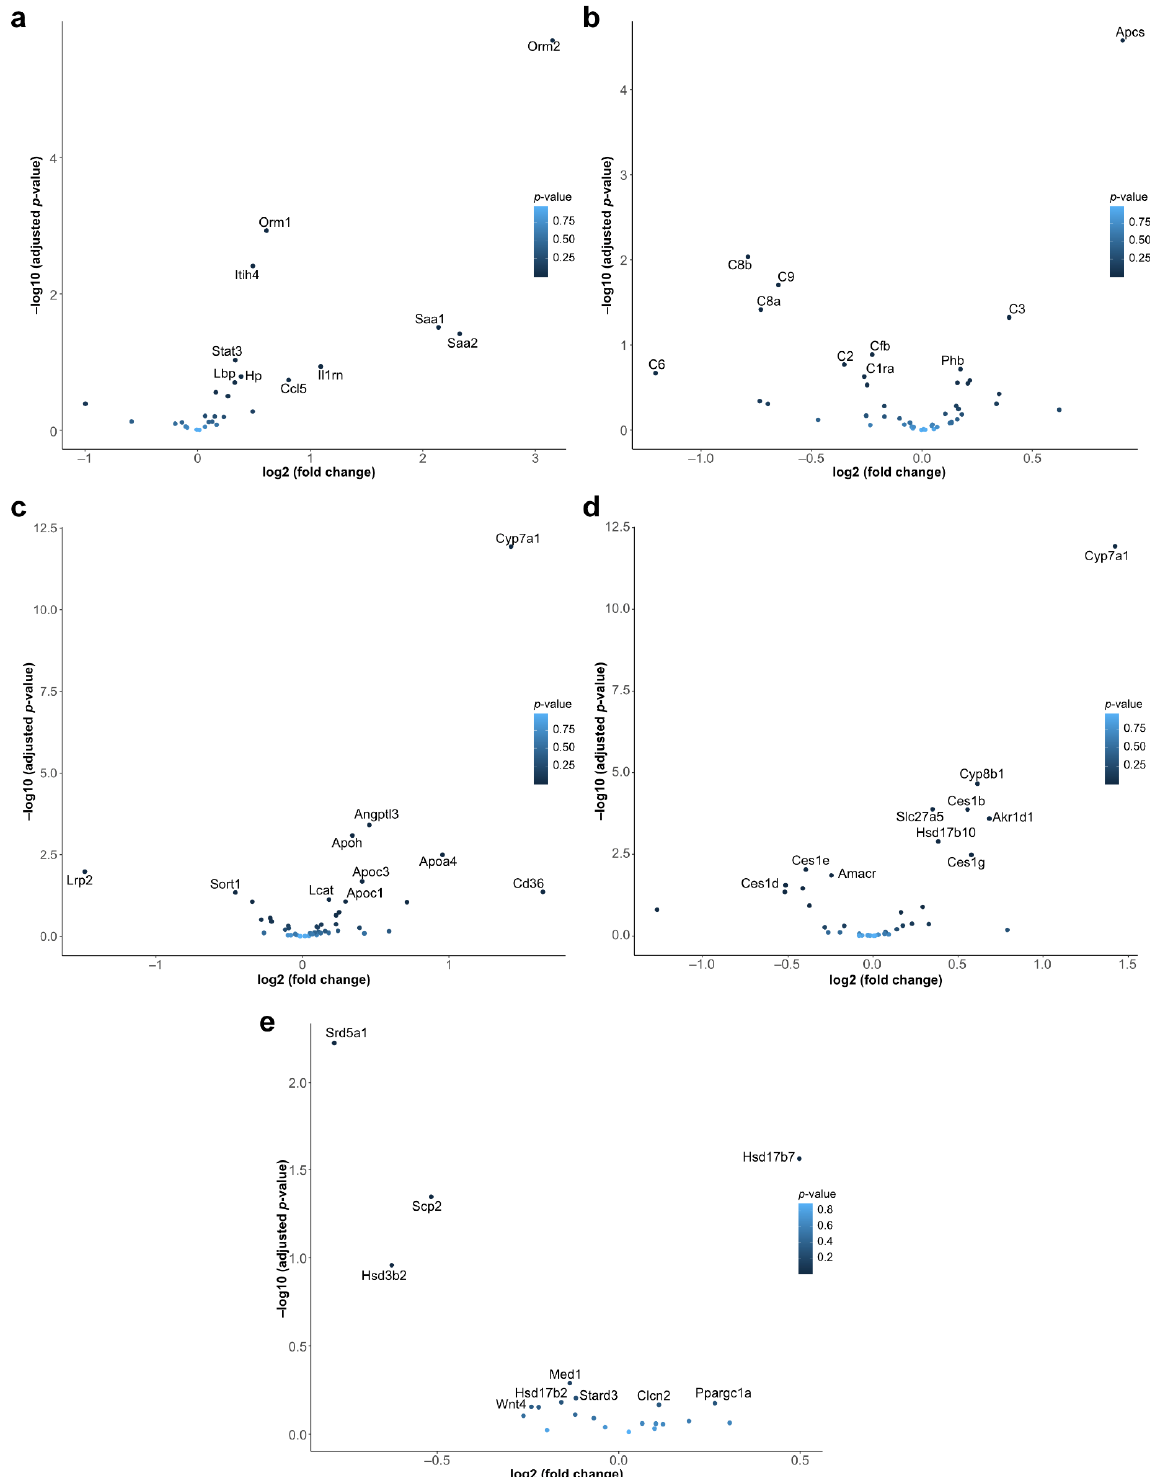
Figure 2. Differential expression of gene sets in Serpina1 KO vs. WT mice. Volcano plots depict the fold-change (x-axis) and significance (y-axis) for genes associated with: ( a ) acute phase response (n = 38); ( b ) complement pathway (n = 187); ( c ) cholesterol metabolism (n = 47); ( d ) bile acid metabolic processes (n = 44); and ( e ) steroid hormone biosynthesis (n = 30). The ten most highly significant DEGs in each pathway are